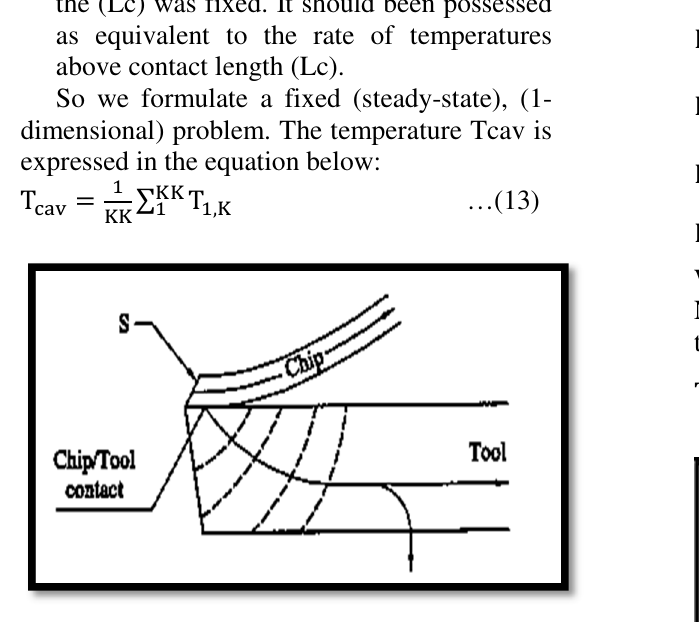
Fig.4.a: The general set up [11].